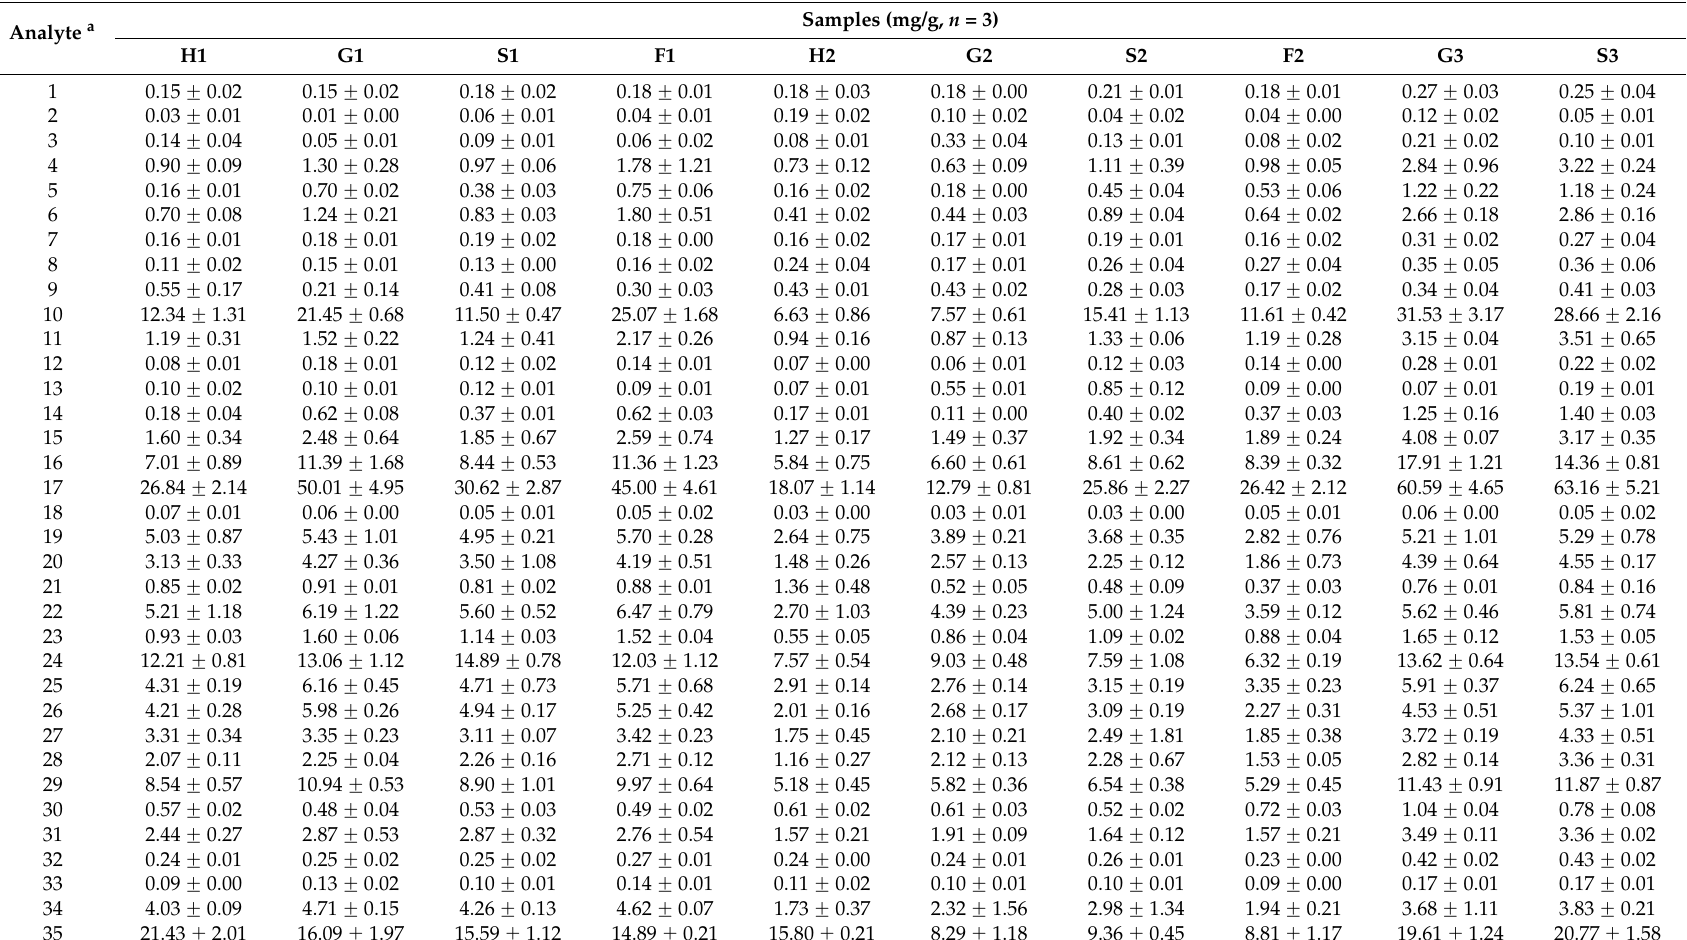
Table 3. Contents (mg/g) of amino acids, nucleosides and nucleobases in Sipunculus nudus